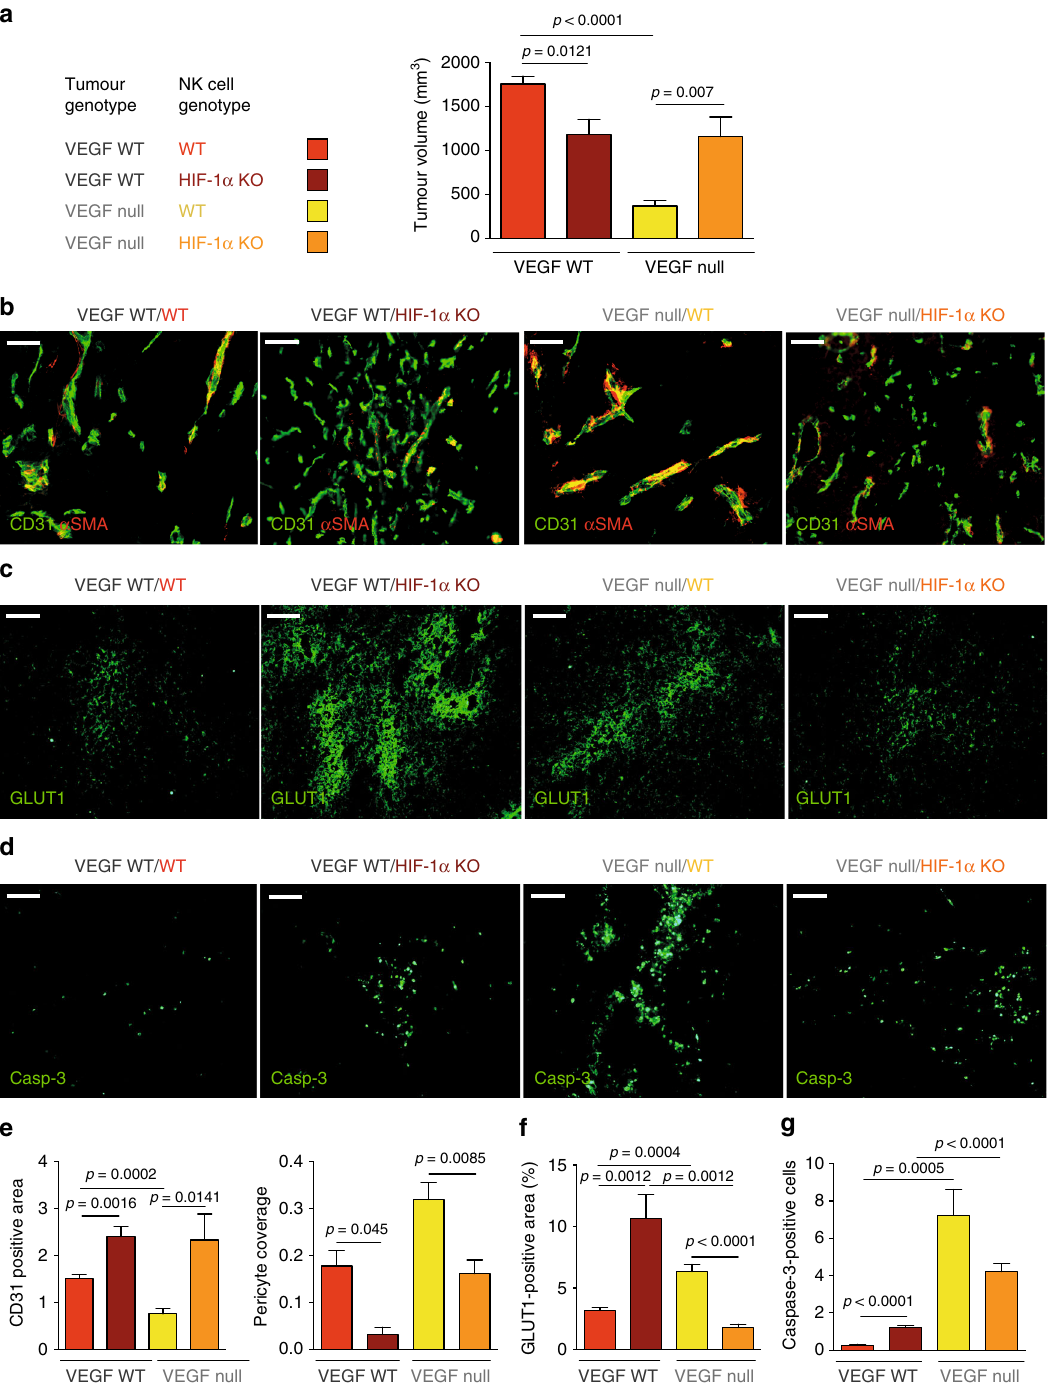
Fig. 7 Deletion of HIF-1 α in NK cells rescues the growth of VEGF-de fi cient tumours. a Tumour volume analysis of VEGF WT and VEGF null fi brosarcoma isografts implanted in WT and HIF-1 α KO mice at endpoint, day 10. b Representative images of CD31/ α -SMA immunostaining on fi brosarcoma isografts. c Representative images of hypoxic areas (GLUT1) in fi brosarcoma isografts. d Detection of apoptotic cells in fi brosarcomas by caspase-3 staining. e Quantitative analysis of CD31-positive endothelial cells and pericyte coverage as assessed by α -SMA/CD31 co-localisation in fi brosacromas at endpoint, day 10. f Quantitative analysis of hypoxic tumour areas at endpoint, day 10. g Quantitative analysis of caspase-3-positive areas at endpoint, day 10 ( n = 7 for each group). Statistical signi fi cance was determined by an unpaired Student ’ s t -test or one-way analysis of variance, where appropriate. Bars represent mean values; error bars indicate the s.e.m. Statistical signi fi cance is indicated as * P < 0.05, ** P < 0.01, and *** P < 0.001. Scale bar, 100 μ